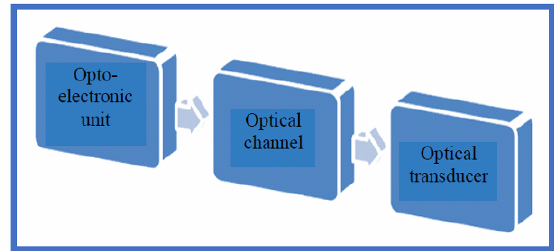
block diagram of